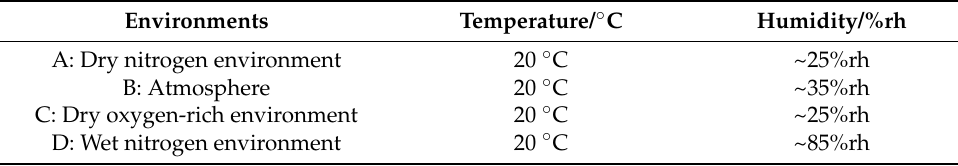
Table 1. Detailed parameters of the storage